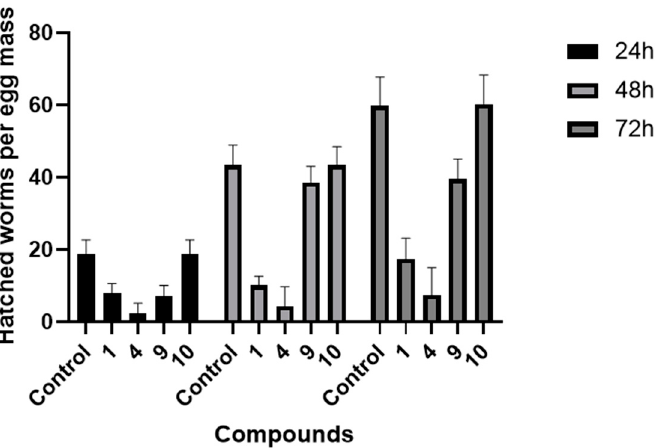
Figure 7. Effects of compounds ( 1 , 4 , 9 , and 10 ) on the egg hatching of M. incognita.